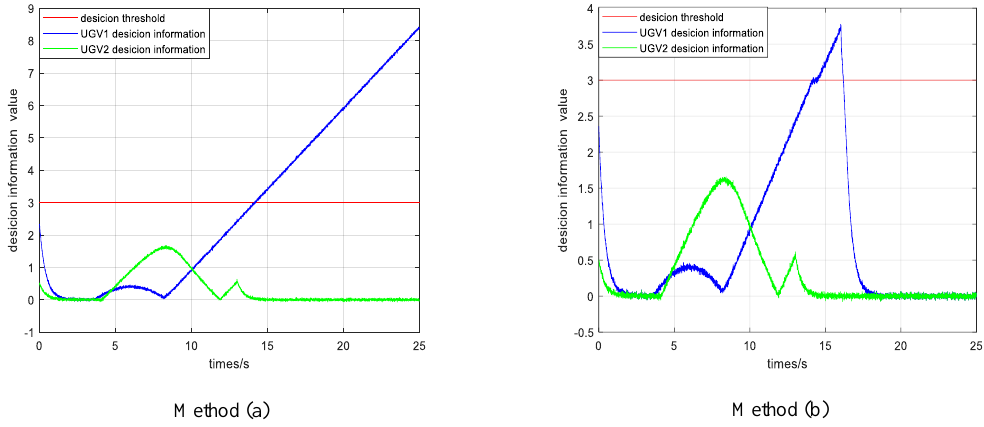
Figure 4. The figure shows the decision variables of method (a) and method